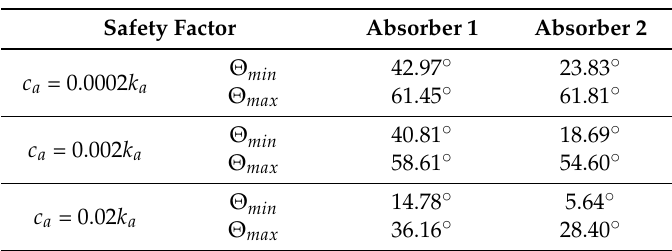
Table 9. Minimum and maximum flexion angle of the absorbers in time domain for different beams’ damping coefficients.